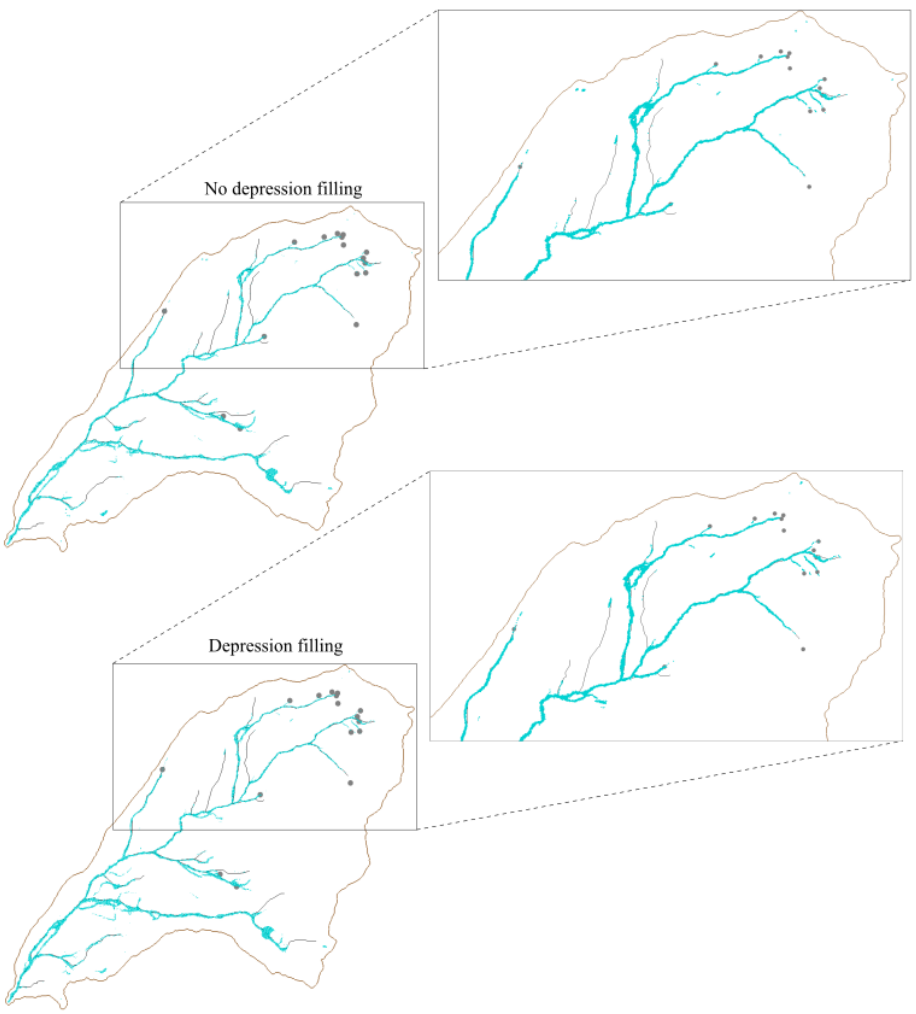
Figure 10. RC1 watershed: channel network tracked by the rain-on-grid approach using the A*-q s scaling law using the original and the filled DEM. The circles represent the channel heads location whereas the black continuous line is the channel network simulated by the best method considered in Orlandini et al. (2011).